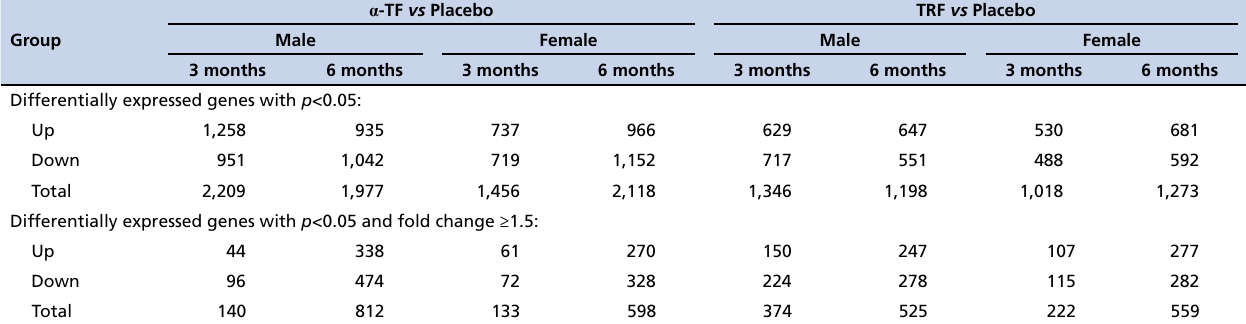
Table 3 - Total number of up- and downregulated genes modulated in male and female subjects after 3 and 6 months of α -TF and TRF supplementation.